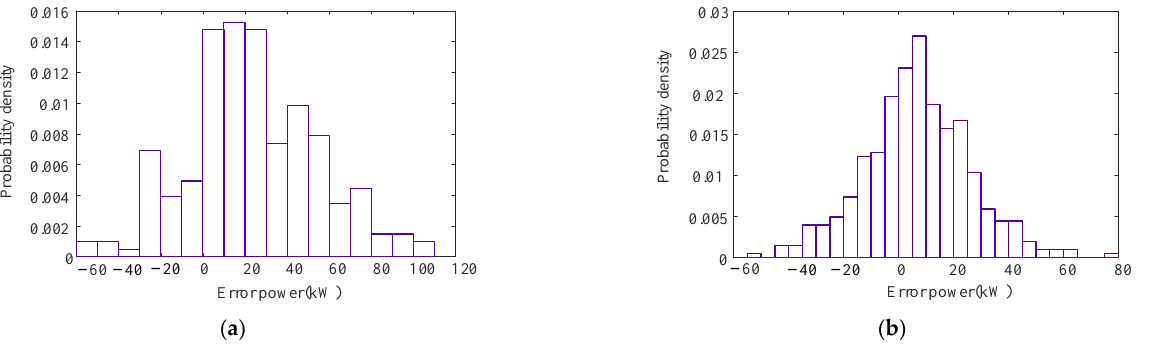
Figure 7. Probability density error distribution between different power interval segments: ( a ) 200–400 kW; ( b ) 400–600 kW.